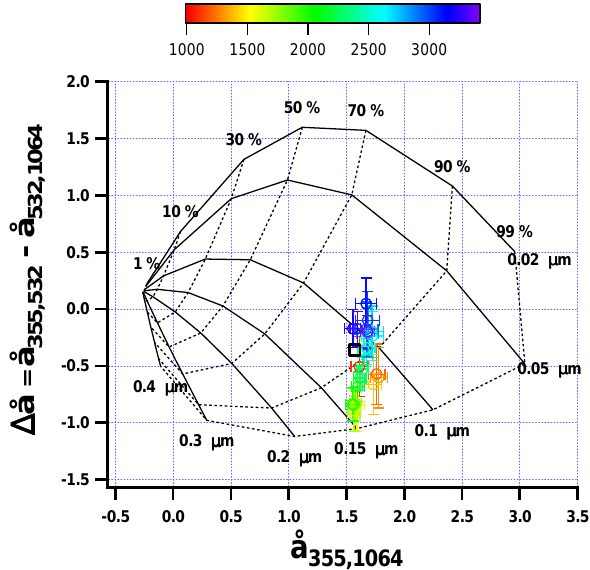
Fig. 6. Scatter plot of 1 å (z) vs. å 355 , 1064 (z) retrieved from the lidar measurements performed on 29 August 2011 within 11:44– Figure 6 (M. R. Perrone et al.) 5 12:19UTC. Different colours represent different altitudes in accor- dance with the colour bar on the top. The open black box represents the 1 å in and å in (355, 1064) data